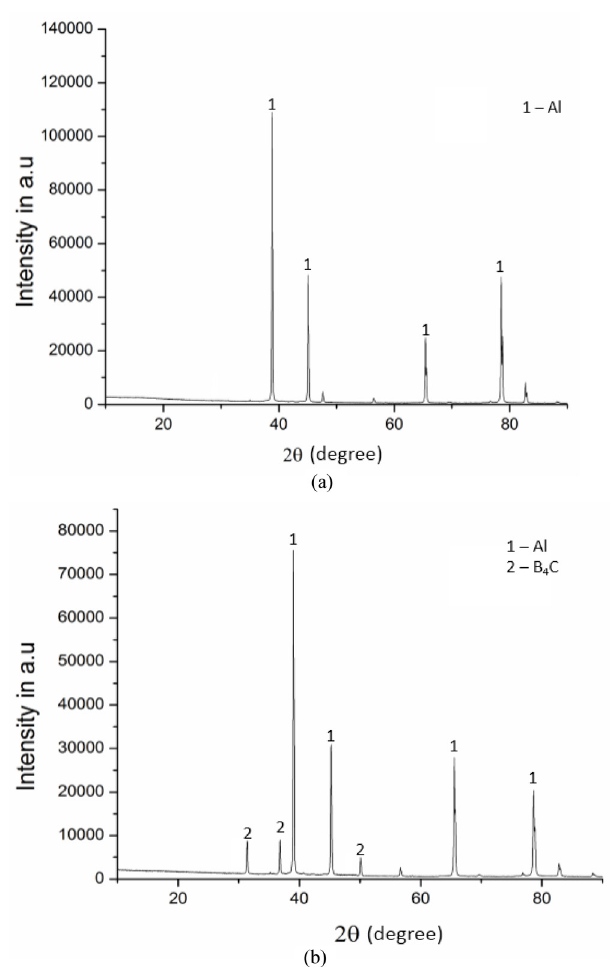
Fig. 7. X-ray diffraction patterns of (a) Al2214 alloy (b) Al2214- 8wt.% of B 4 C composites.